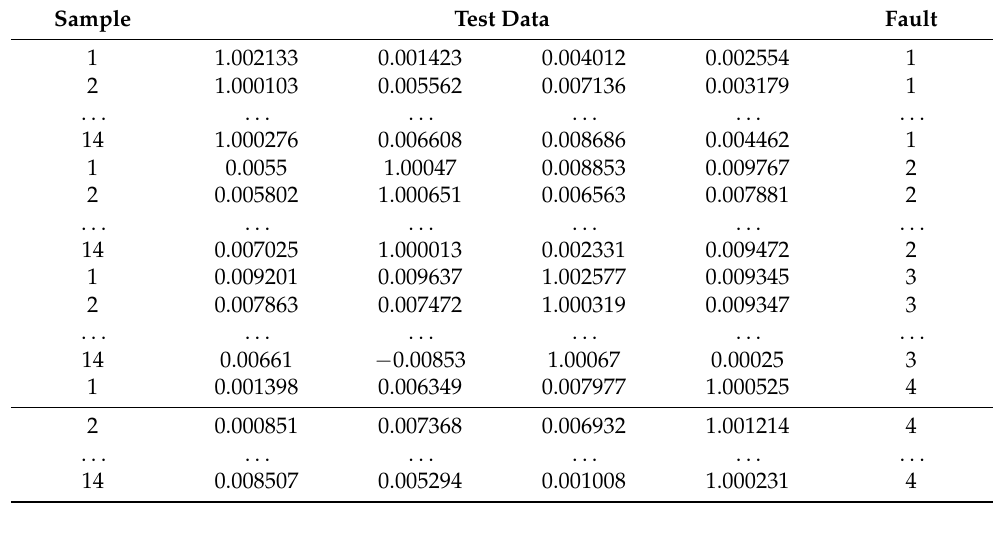
Table 7. GA-BP algorithm experimental test data.